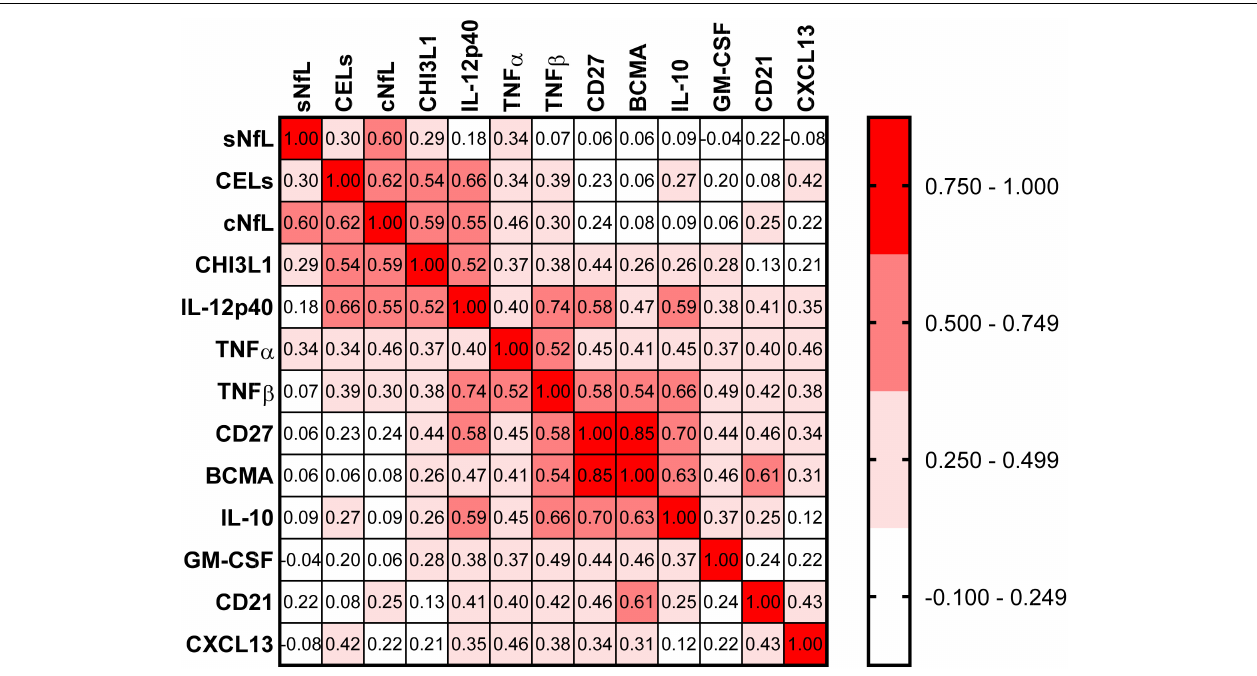
FIGURE 5 | In the training cohort, correlations between all biomarkers were analyzed using Spearman analysis. In correlogram, the color intensity of each cell denotes the correlation coefficient (Spearman Rho) for correlation between respective biomarkers. All biomarkers were analyzed, but only biomarkers which have at least one statistically significant ( p < 0.01) correlation are depicted